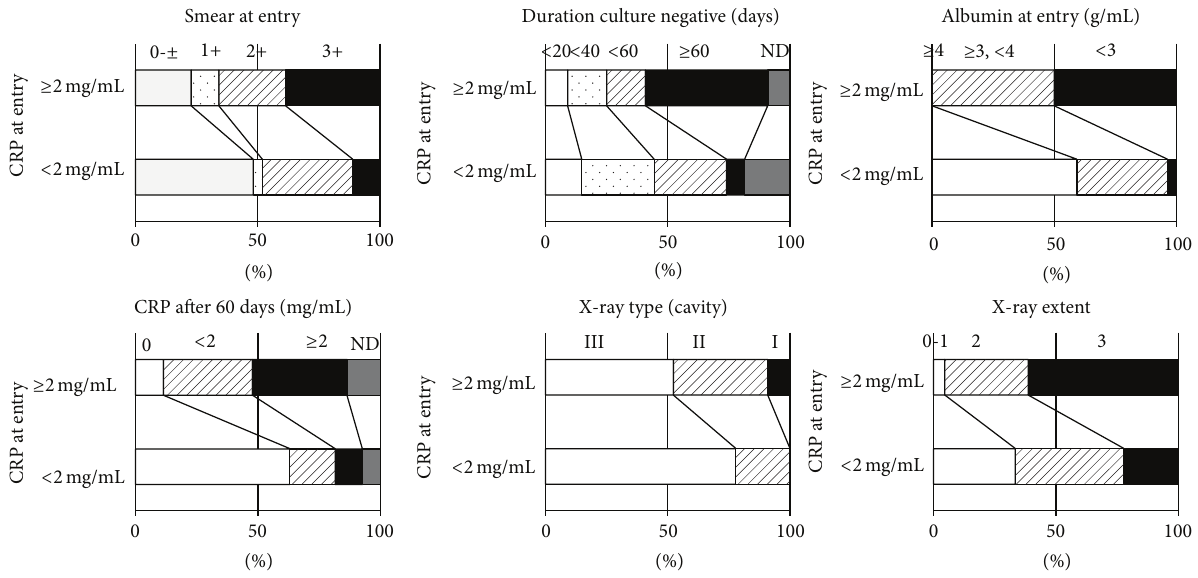
Figure 4: Clinical markers evaluated with “CRP at entry.” All markers were significantly associated with “CRP at entry.” “CRP at entry” was significantly associated with “Smear at entry” ( 𝑟 = 0.296 , 𝑃 < 0.05 ), “Duration of culture negative” ( 𝑟 = 0.391 , 𝑃 < 0.01 ), “Albumin at entry” ( 𝑟 = 0.687 , 𝑃 < 0.01 ), “CRP at 60 days” after treatment ( 𝑟 = 0.528 , 𝑃 < 0.01 ), X-ray type (cavity) ( 𝑟 = 0.271 , 𝑃 < 0.05 ), and X-ray extent ( 𝑟 = 0.445 , 𝑃 < 0.01 ).